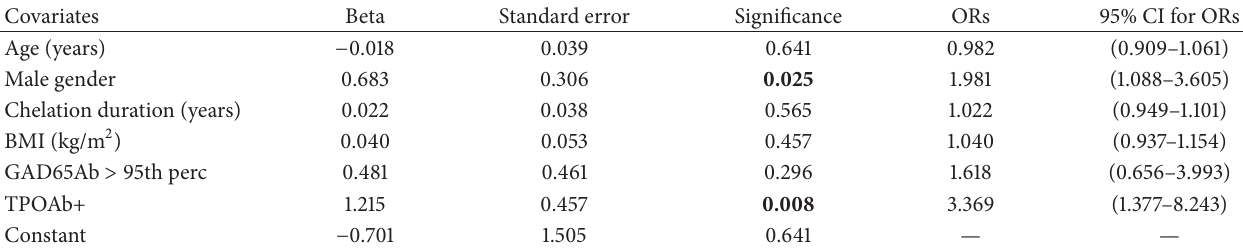
Table 2: Multiple logistic regression analysis to test the association between covariates and the probability of developing alteration of glucose metabolism (IGT or overt diabetes).